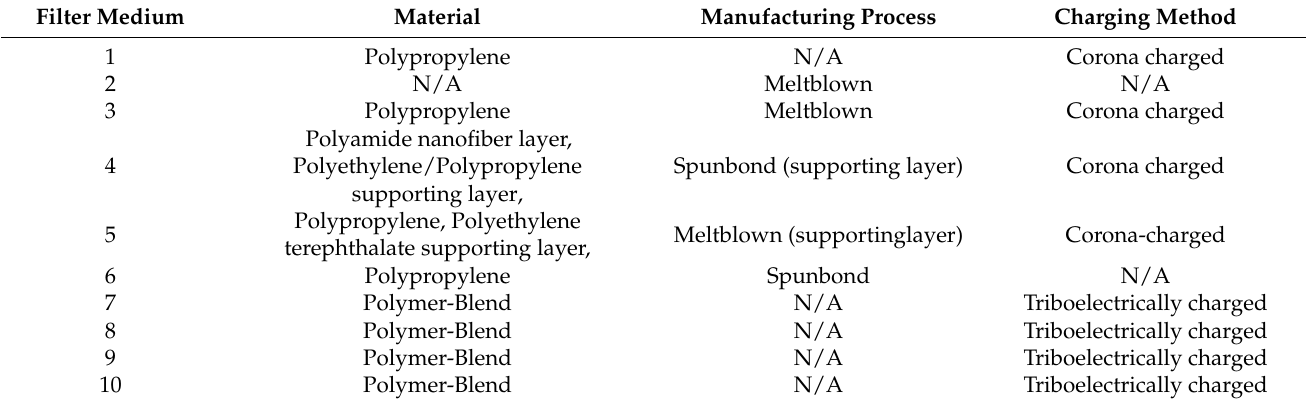
Table 1. Investigated filter media. Specification of material, manufacturing process, and charging methods. Filter